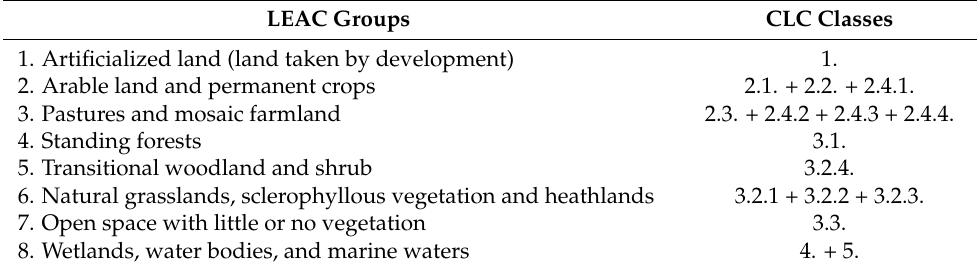
Table 2. LEAC groups and corresponding CLC